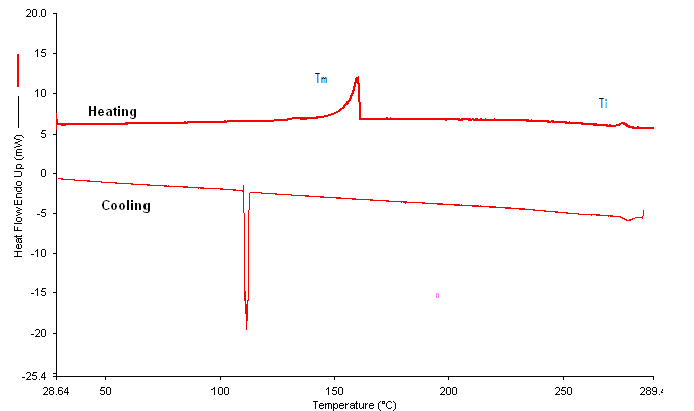
Figure 4. DSC thermogram of diol 2b.